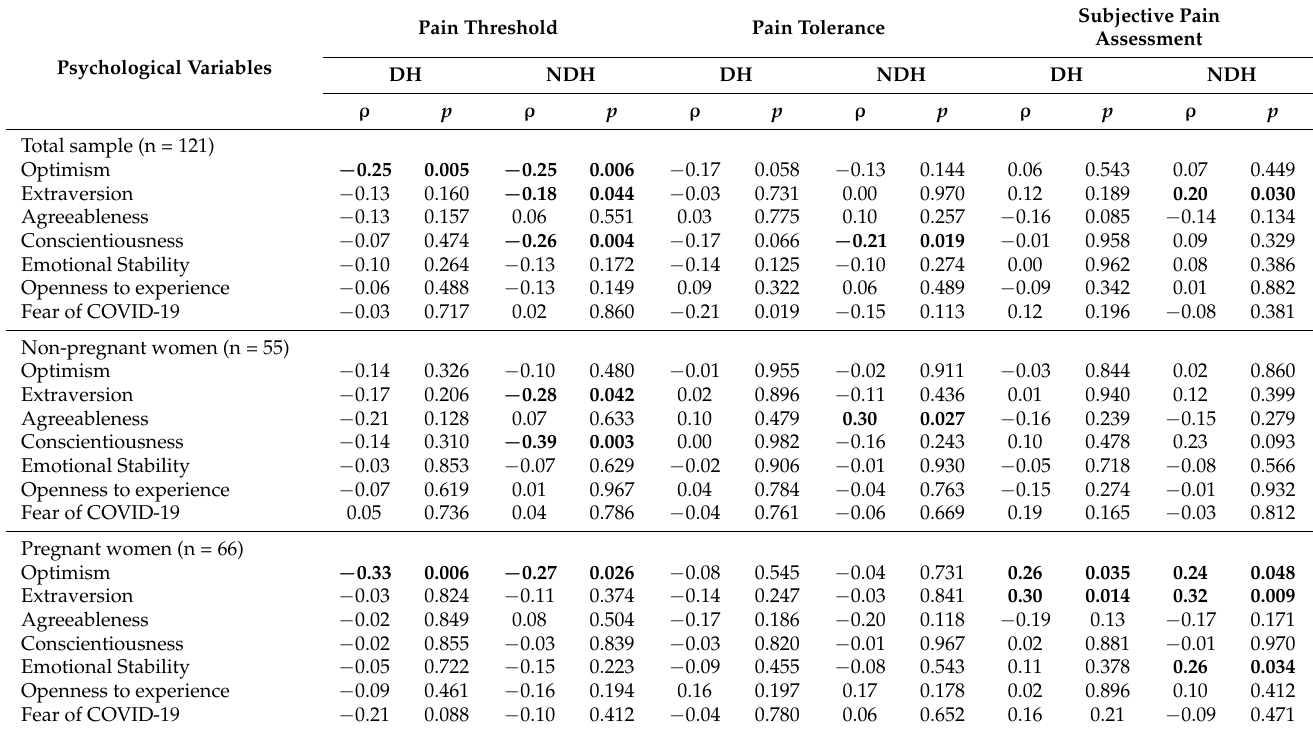
Table 3. Correlations between pain sensitivity indicators and psychological traits in the total sample, in non-pregnant